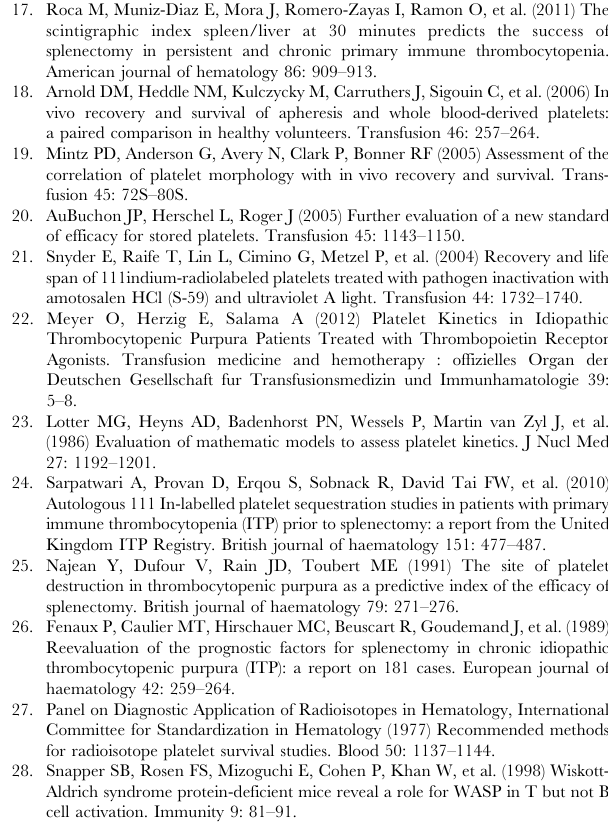
trendline with a fixed intercept at T0 = 100% is shown. Error bars are standard deviations. (TIFF) Table S1 Equilibration-verified parameter space volumes (PS) searched for WT to WT data set. Resolution is 5% of the range for each axis. (TIFF) Table S2 PS volumes searched during jacknife resampling of data sets. Resolution is 10% of the range for each axis. For a small number of data subsets, LMs fell at the edge of the ranges shown. These were re-evaluated in adjacent volumes of PS at the same resolution. (TIFF) Text S1 Additional details on optimal parameter searches and other statistical